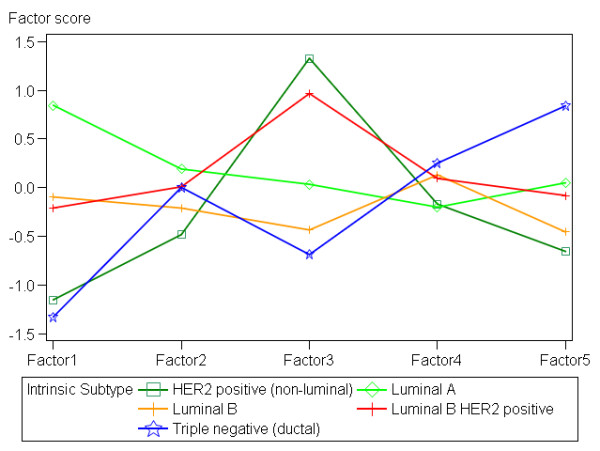
Representation of the factor score profiles of the intrinsic subtypes. The multiple line chart outlines the factor score profiles of the intrinsic subtypes. The lines connect the mean values of the factor 1-5 scores obtained by one-way ANOVA for each intrinsic subtype as explanatory variable.